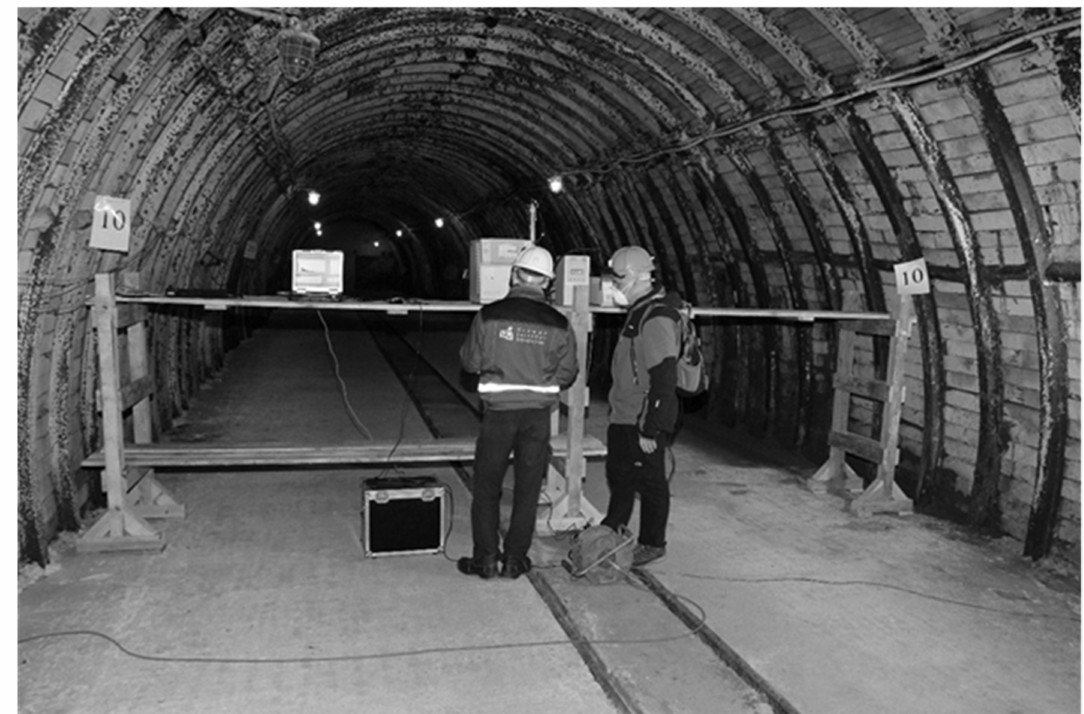
Figure 2. GIG Experimental Mine ‘Barbara’, level 30 m. The area of conducted research works and a view of the support structure for particle